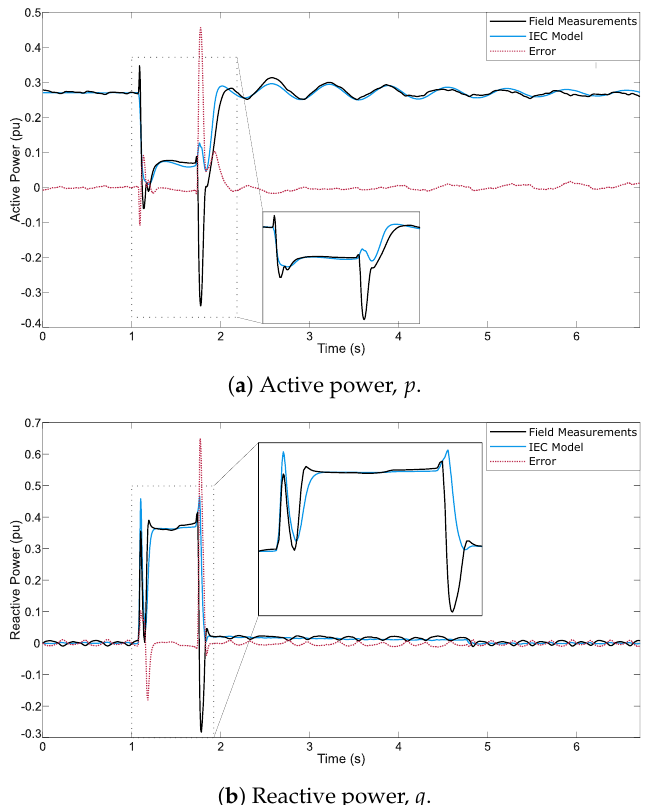
Figure 6. Active and reactive power comparison between the field measurements and the simulation responses of a DFIG Siemens Gamesa WT under a voltage dip. TC2, WT operating at partial load